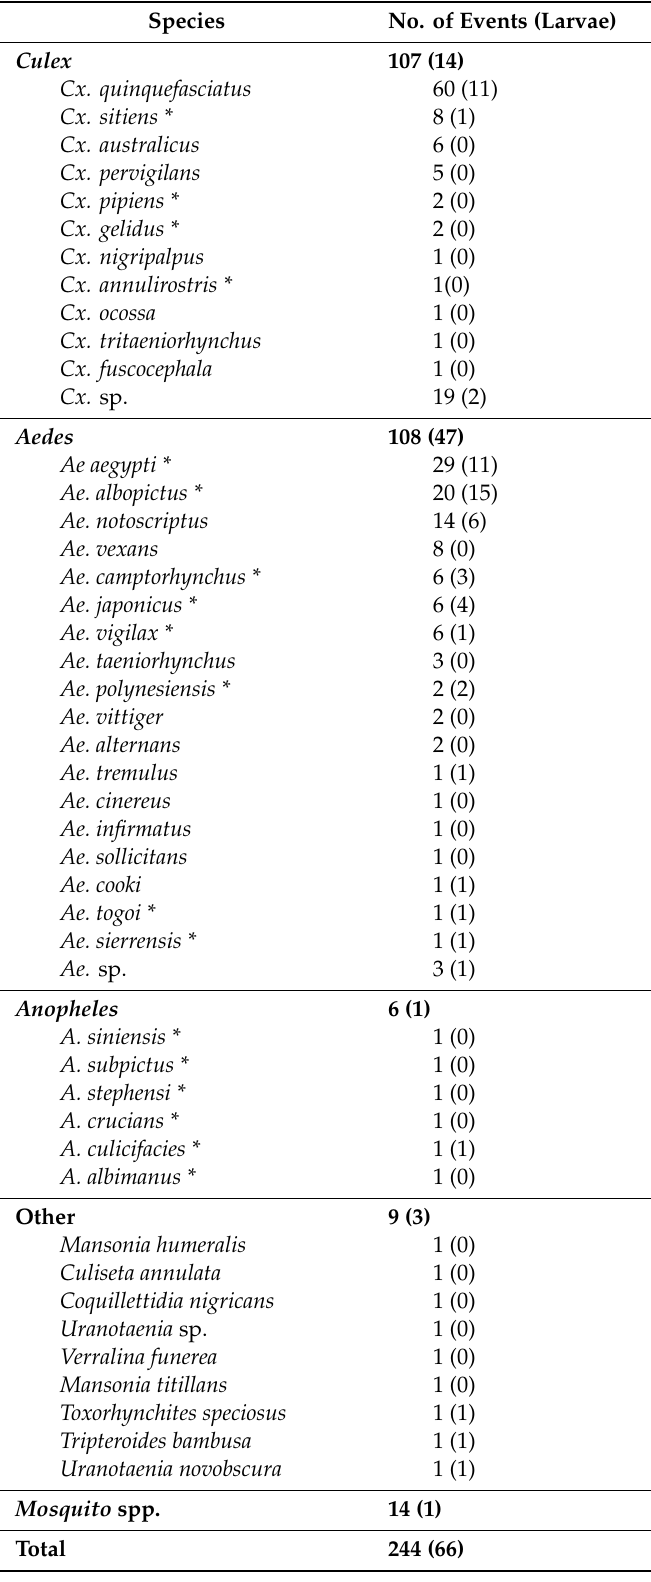
Table 1. Species and development stages of mosquito interception events in New Zealand, July 2001–March 2018. * On Ministry of Health “Unwanted Organisms